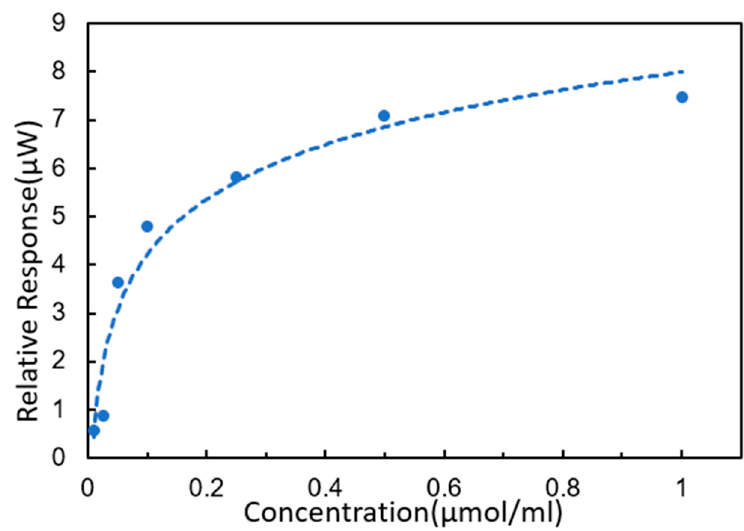
Figure 9. Standard curve of target DNA sequences.